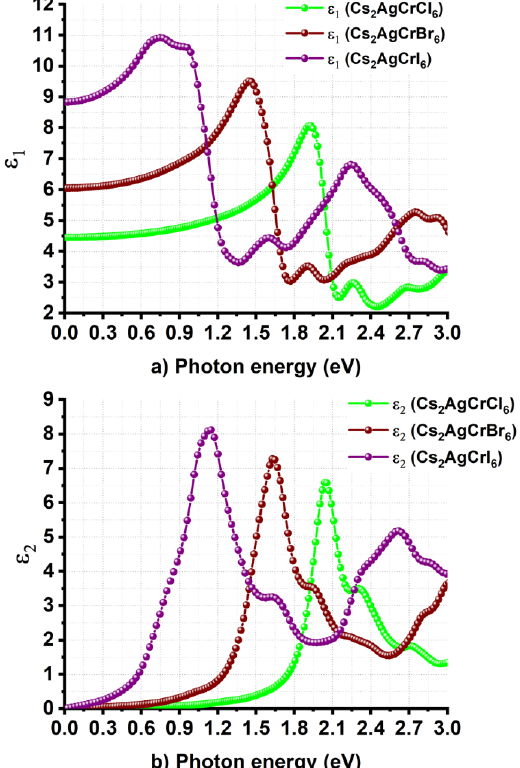
Figure 6. Nature of dependence of the ( a ) real and ( b ) imaginary part of dielectric function on the photon energy for Cs 2 AgCrX 6 (X = Cl, Br, I).